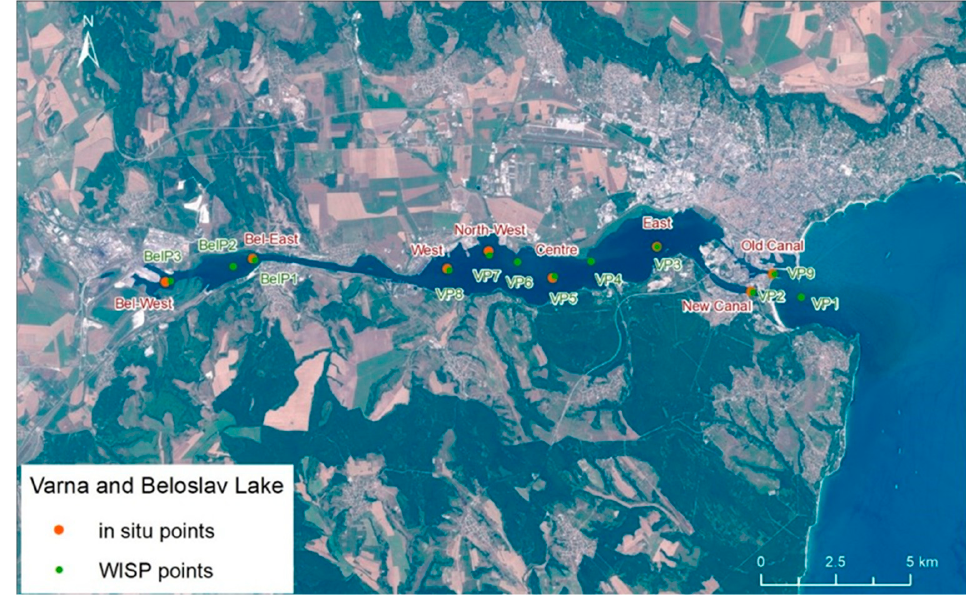
Figure 5. Varna Lake measurement stations of the standard monitoring reporting and the measured with field hyperspectrometer points in the EMOWAF project.